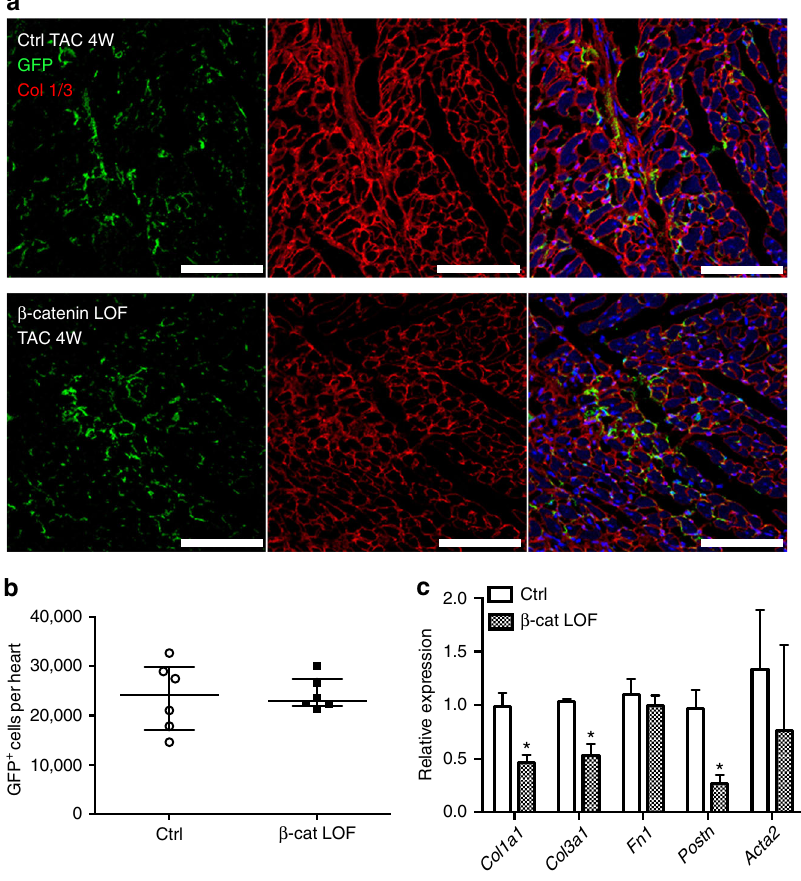
Fig. 6 The total number of Tcf21GFP + CFs is not altered, but fi brotic ECM gene expression is reduced, with loss of β -catenin in Tcf21 lineage CFs 4 weeks after TAC. a Representative images of Tcf21 MCM ;R26 mTmG ;Ctnnb1 fl / + (Ctrl, top ) and Tcf21 MCM ;R26 mTmG ;Ctnnb1 fl / fl ( β -catenin LOF, bottom ) with immunostaining for GFP ( green ) and collagen 1/3 (Col1/3, red ) are shown. b GFP + Tcf21 lineage CFs were isolated by FACS ( fl uorescence-actived cell sorting) and the number of GFP + cells was quanti fi ed in Tcf21 MCM ;R26 mTmG ;Ctnnb1 fl / fl and control mice 4 weeks after TAC. c mRNA was isolated from sorted Tcf21 lineage GFP + cells. Expression of Col1a1 , Col3a1 , and Postn was signi fi cantly lower in CFs from Tcf21 MCM ;R26 mTmG ;Ctnnb1 fl / fl mice compared to controls, but Fn1 and Acta2 was not changed as determined by quantitative PCR. Data points are shown with median and interquartile ranges indicated. Statistical signi fi cance was determined using unpaired Mann – Whitney U tests: * P < 0.05. N = 6 mice per groupFluorescence-actived cell sorting